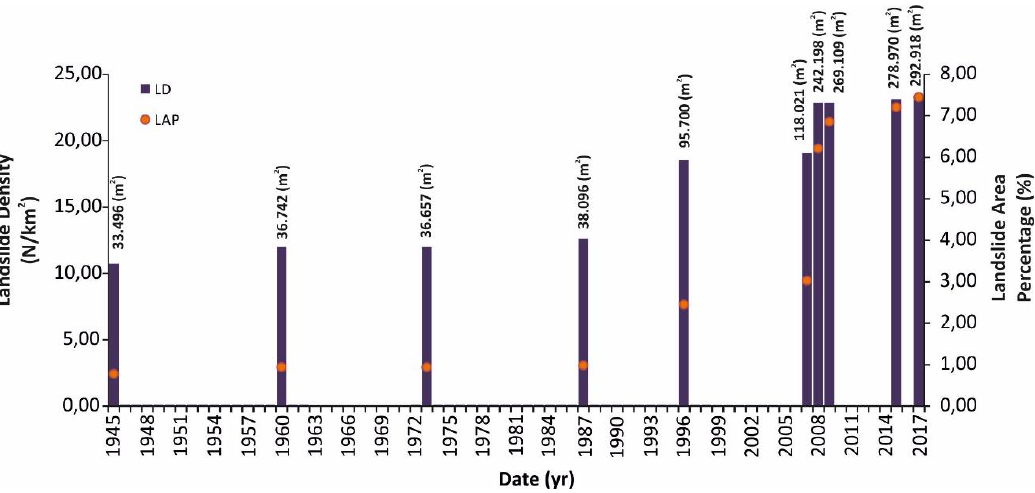
Figure 10. Landslide density and landslide area percentage versus date. The columns represent the landslide density and the dots the landslide area percentage. The labels on the columns indicate the extent of the affected area.